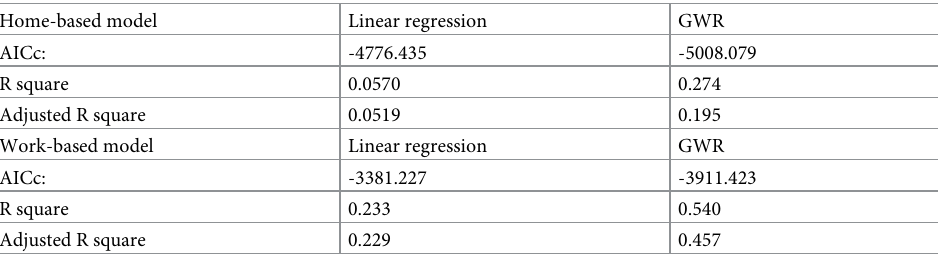
Table 2. GWR model